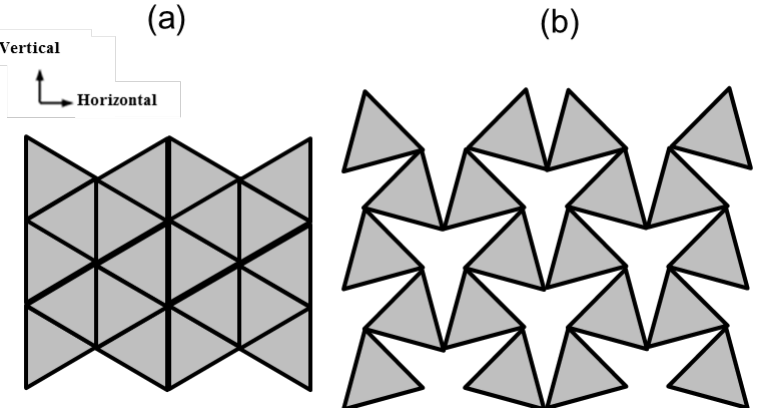
Figure 9. Schematic showing ( a ) rotating triangles (un-deformed); ( b ) rotating triangles’ multi axial expansions (rotation = 15°), tensile load applied either vertically or horizontally.